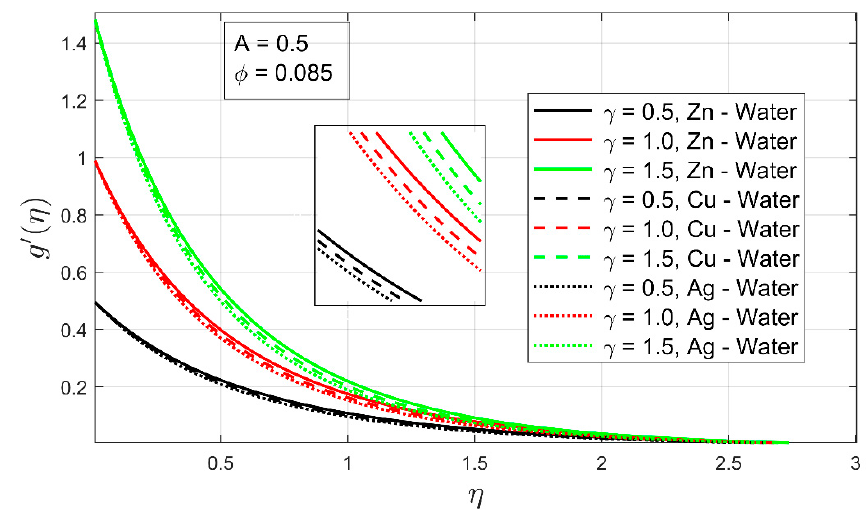
Figure 7. The influence of stretching ratio γ on the velocity profile g (cid:48) ( η ) .